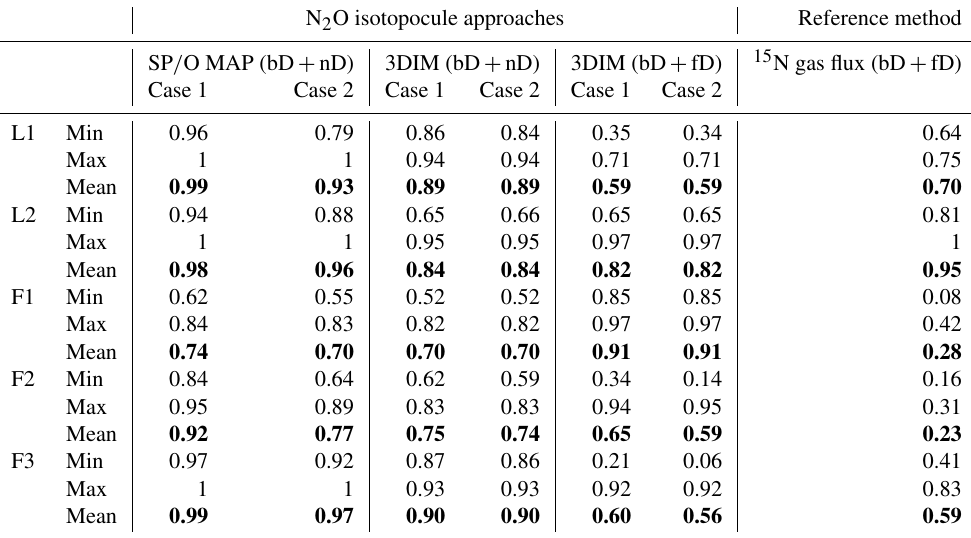
Table 4. Comparison of N 2 O fraction originating from bD ( f bD ) determined with the N 2 O isotopocule approaches (SP / O MAP and 3DIM) and the reference method ( 15 N gas flux). Due to methodical assumptions for the particular approach, either the bD + nD fraction (for SP / O map and 3DIM) or the bD + fD fraction (for 3DIM and the reference method) can be compared (see Sect.